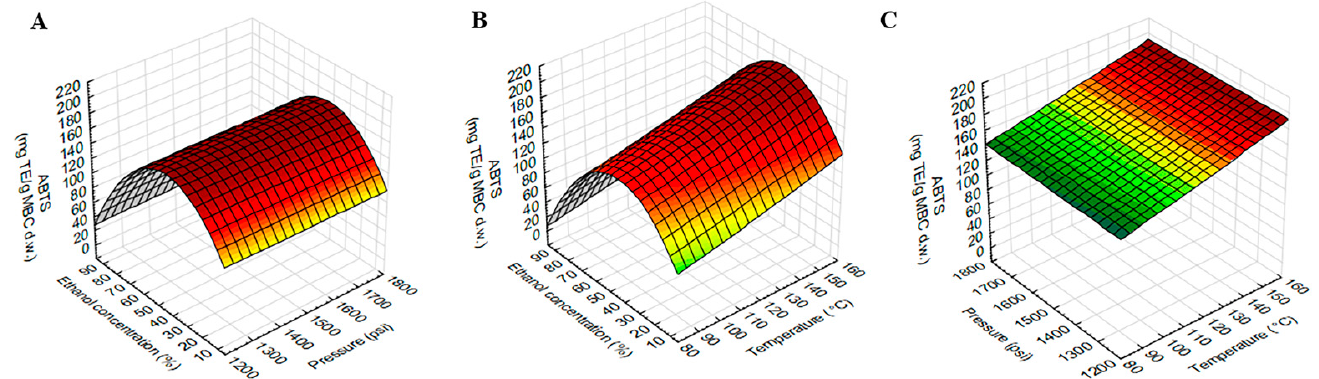
Figure 4. Response surface plots showing the interaction effects of extraction variables on ABTS of MBC extract. ( A ) pressure and ethanol concentration at constant temperature (120 ◦ C), ( B ) temperature and ethanol concentration at constant pressure 1500 psi and ( C ) temperature and pressure at constant ethanol concentration (50%).